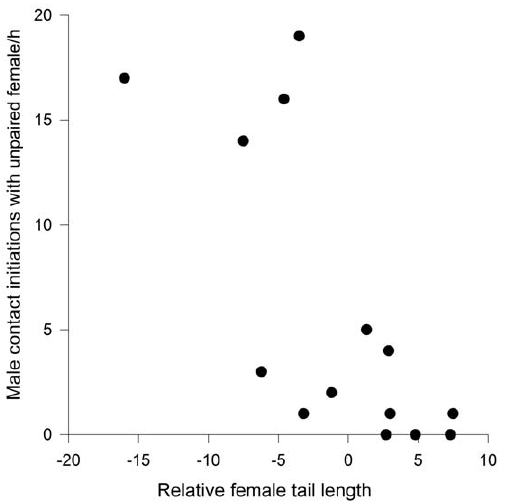
Figure 4. Relationship between a male’s contact initiations towards an unpaired female and the relative tail length of his partner. The focal female’s attractiveness increases in relation to the unpaired female’s attractiveness along the x-axis.